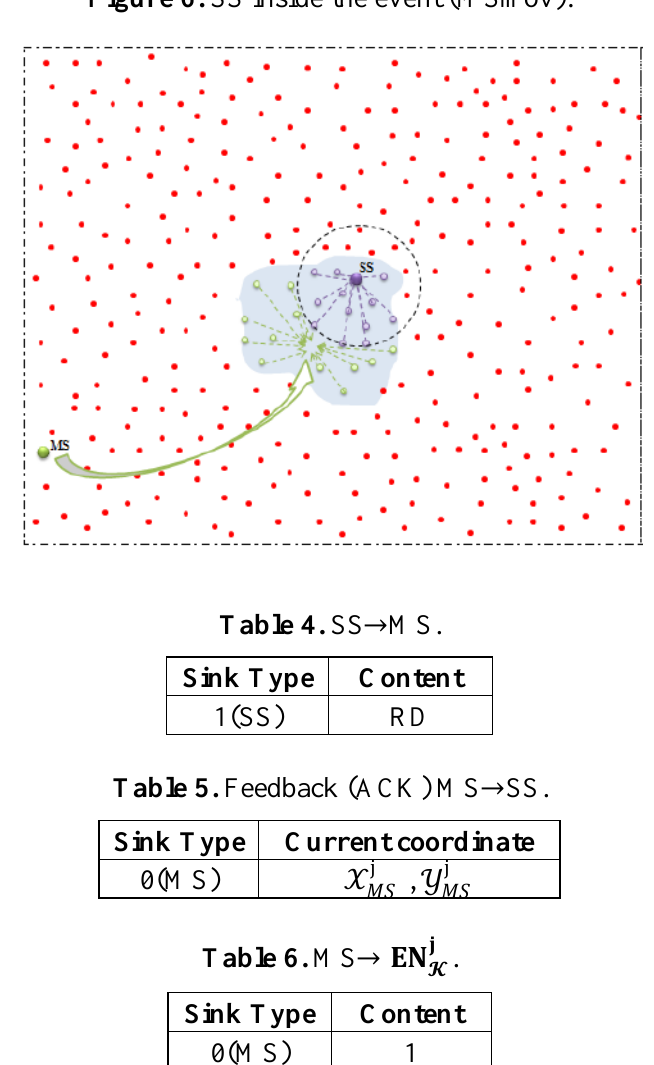
Table 6. MS → 𝐄𝐍 𝓚𝐣